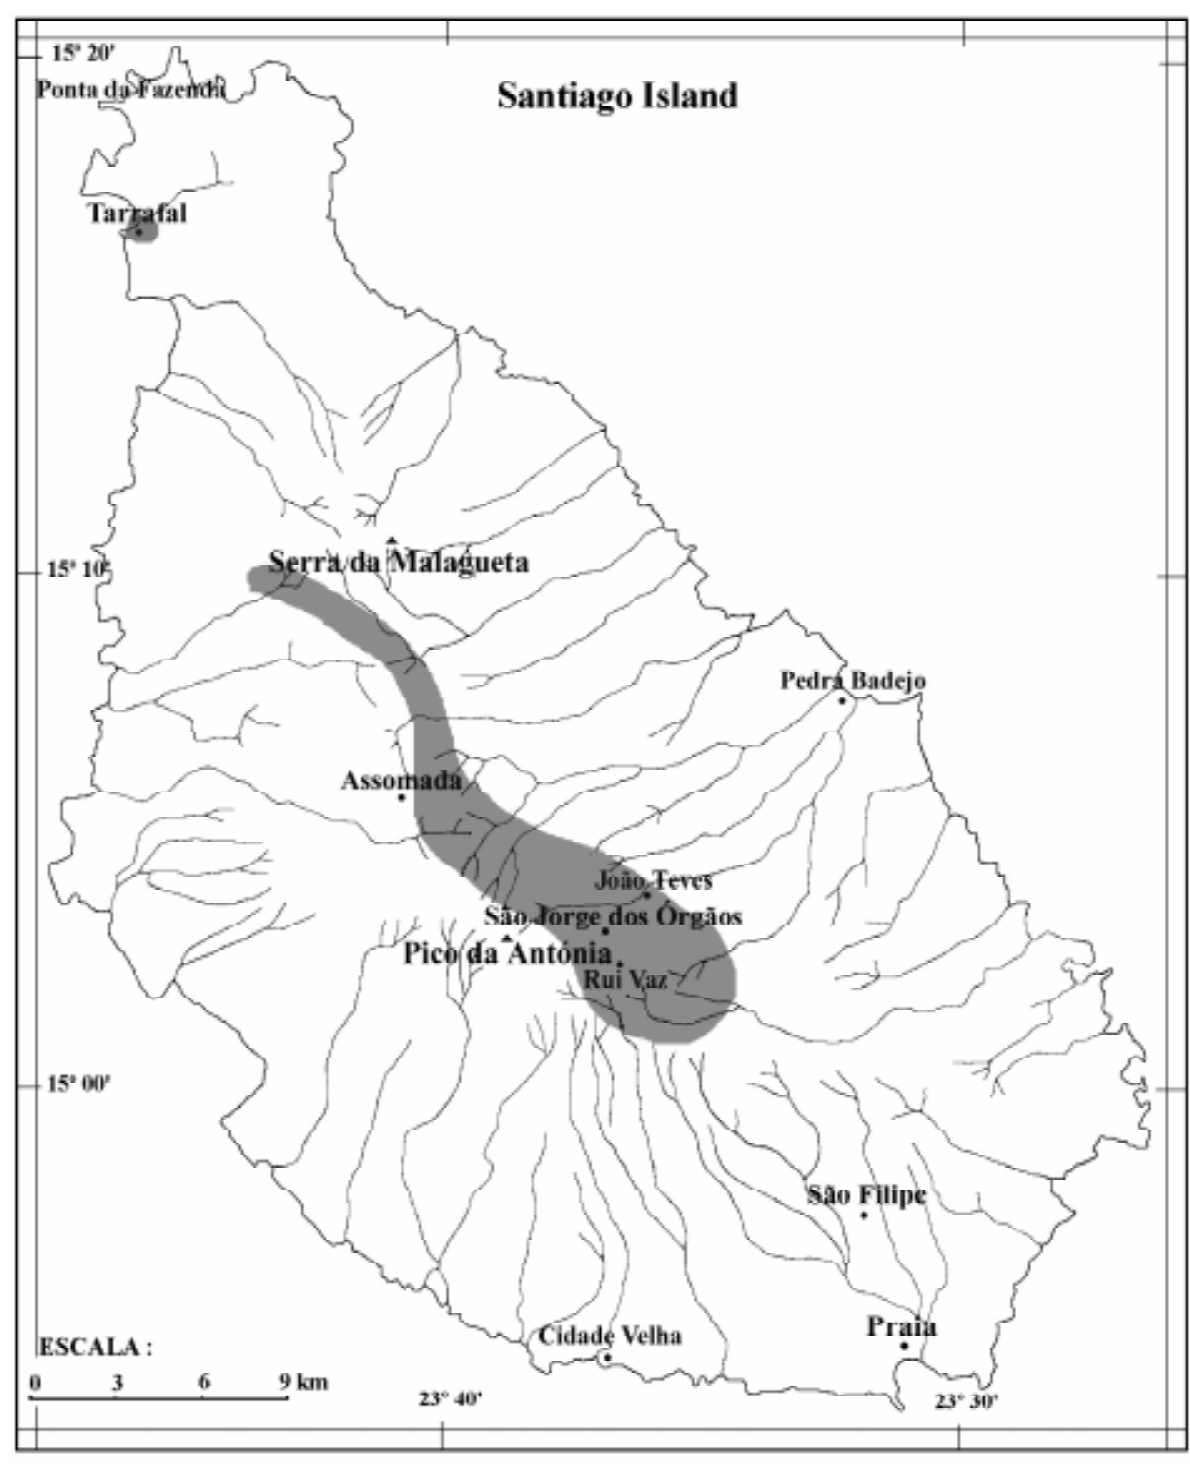
Fig. 1. Location of sites sampled for Magnaporthe grisea hosts in Santiago Island, Cape